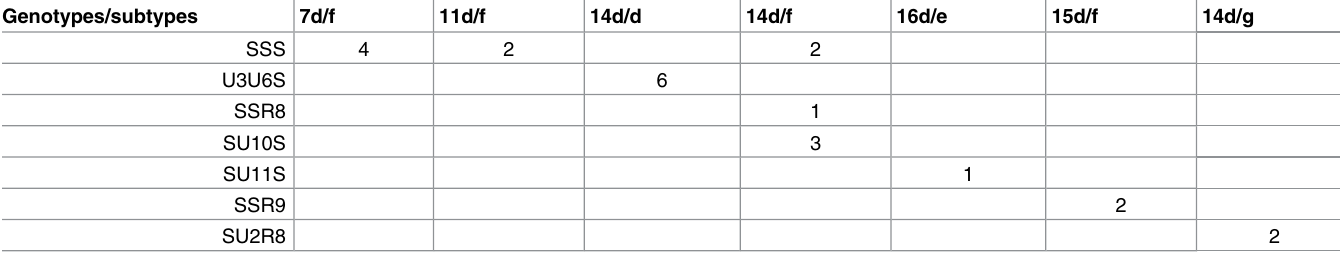
Table 4. Comparison of fully typed clinical isolates using ECDCT and SBMT. Only sampleswith fully-typedgenotypes in both typing schemes are shown.